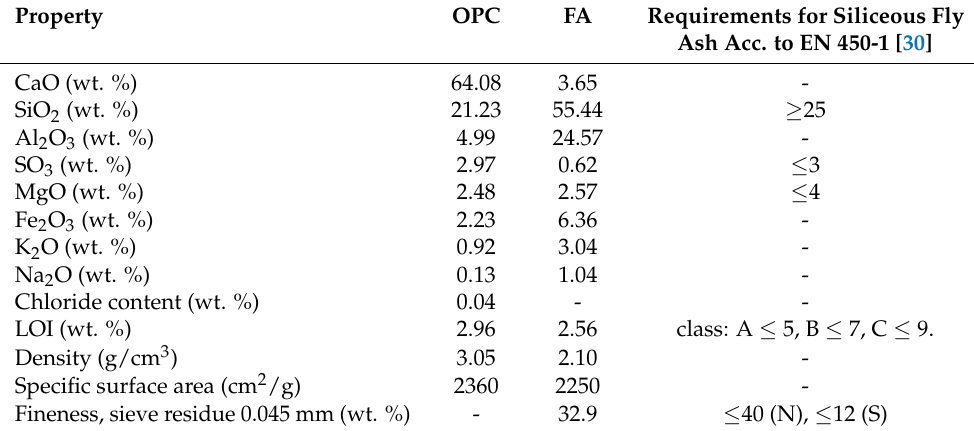
Table 1. Chemical compositions and physical properties of the materials.